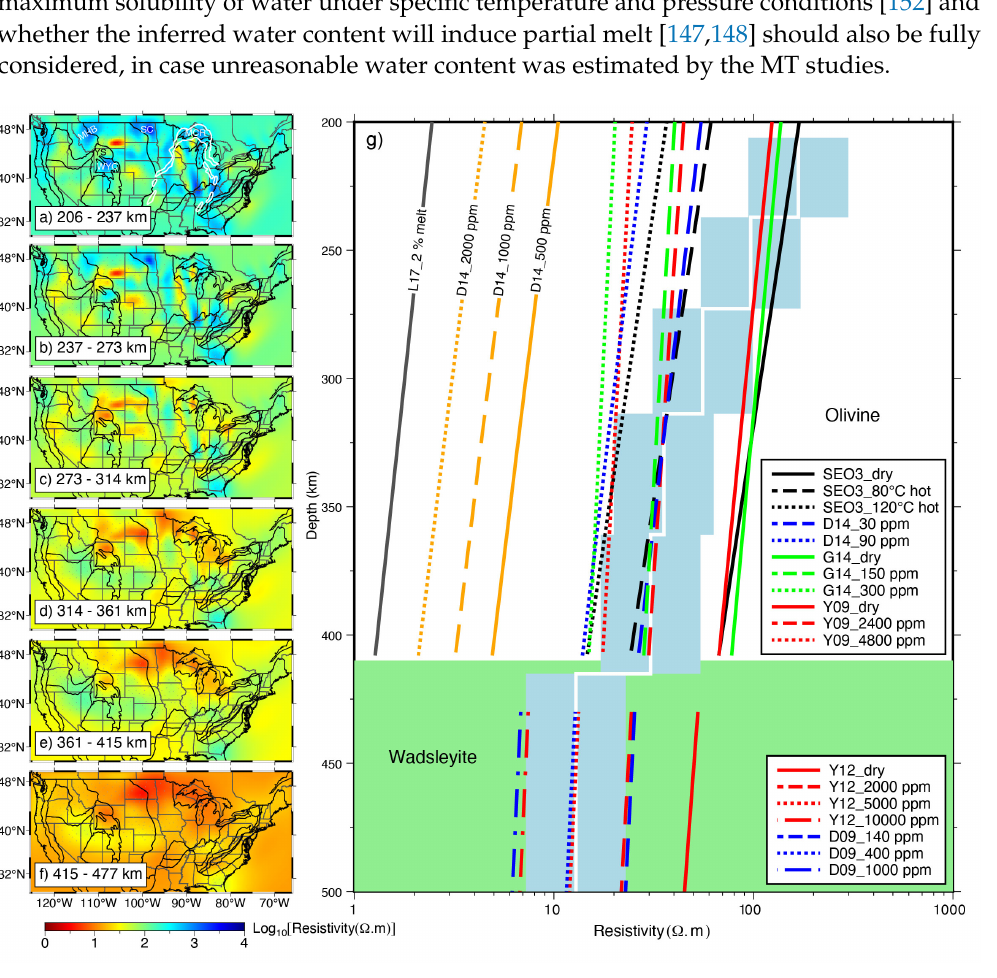
Figure 11. MT resistivity model of the continental United States and its implications for water content or temperature modified after Yang et al. [73]. SEO3: Constable [44]; D14: Dai and Karato [61]; G14: Gardès et al. [58]; Y09: Yoshino et al. [45]; Y12: Yoshino and Katsura [65]; D09: Dai and Karato [60]; L17: Laumonier et al.